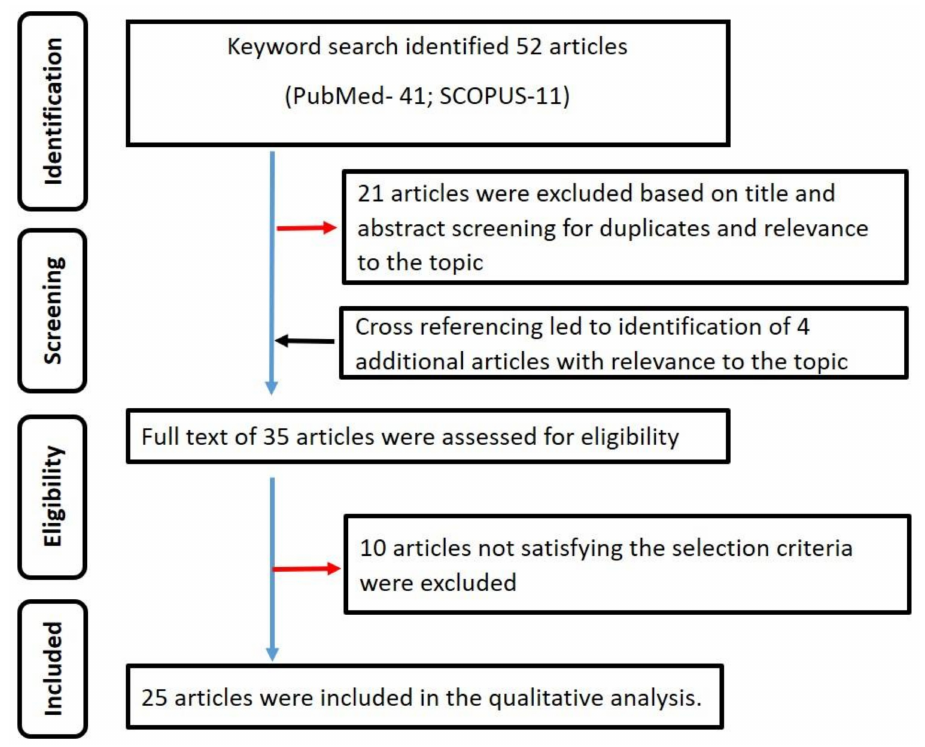
Figure 1. Summary of the search strategy employed in the qualitative